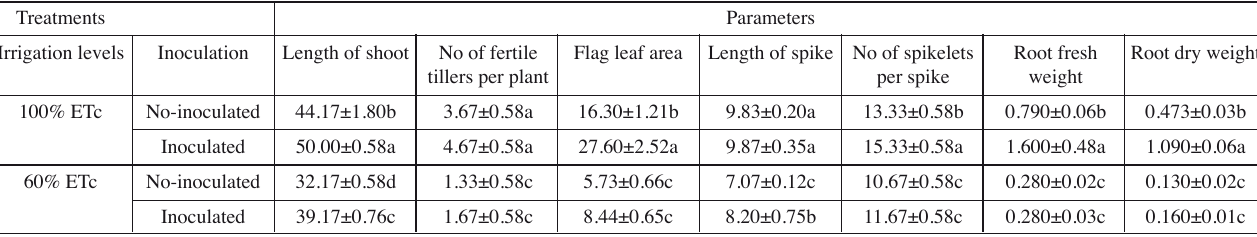
Tab. 1: Effect of Azospirillum lipoferum inoculation on the growth traits [length of shoot (cm), No of fertile tillers per plant, flag leaf area (cm 2 ), length of spike (cm), No of spikelets per spike, root fresh mass (g) and root dry mass (g)] of wheat ( Triticum aestivum L., cv. Giza-168) plants grown under non-stressed and drought-stressed